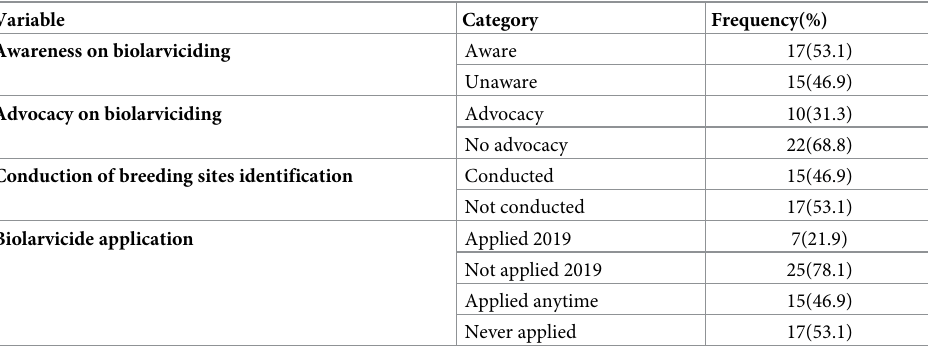
Table 6. Content analysis for key informants’ views on the implementation of biolarviciding (n =